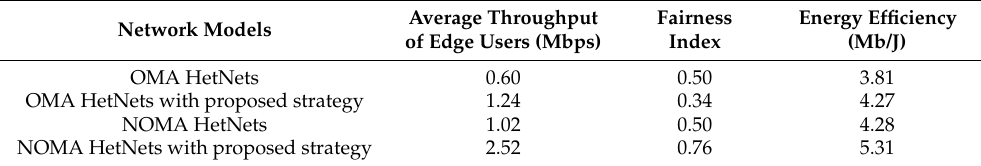
Table 4. Simulation results under different network models. Network